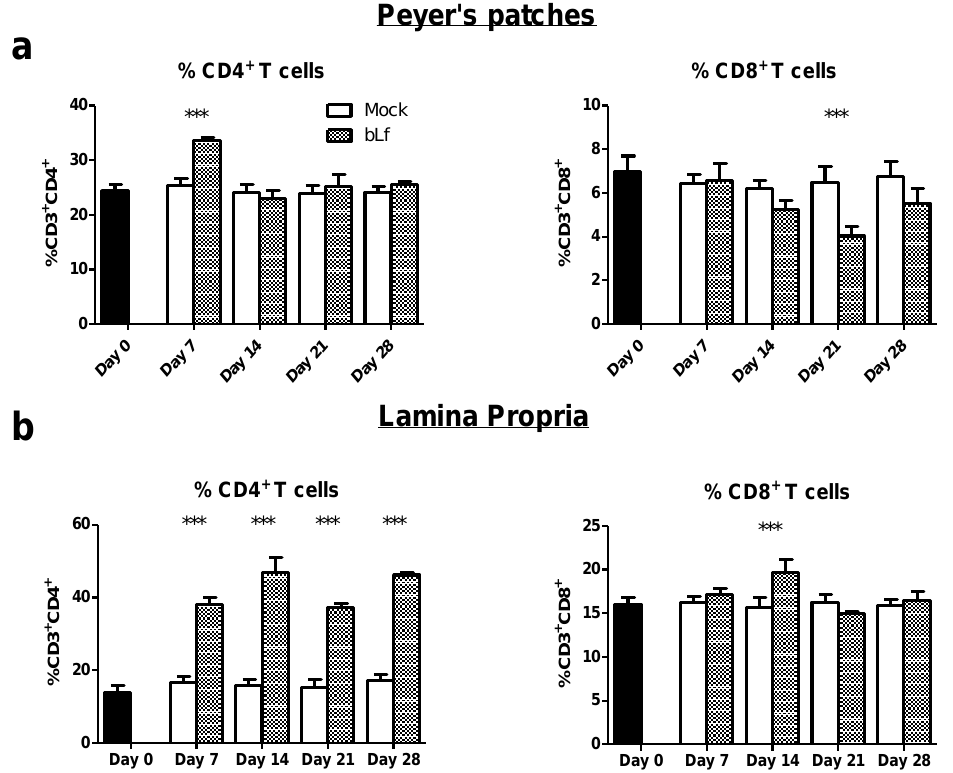
Figure 2. Effects of oral bLf vs. mock on the percentages of CD4 + and CD8 + T cells in PP ( a ) and LP ( b ) of the proximal small intestine. Mean and SD are shown. Significant differences: *** p ≤ 0.001 compared to mock. Non-significant results are omitted.